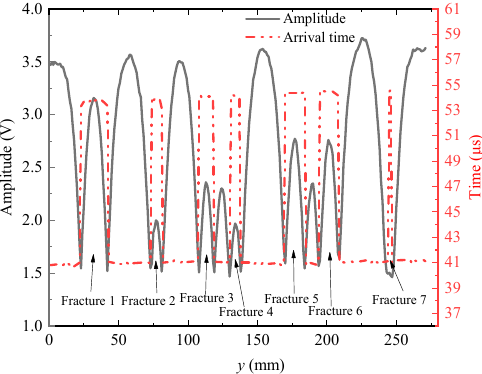
Figure 16. Echo amplitudes and arrival times for grooved sandstone Plate 2.